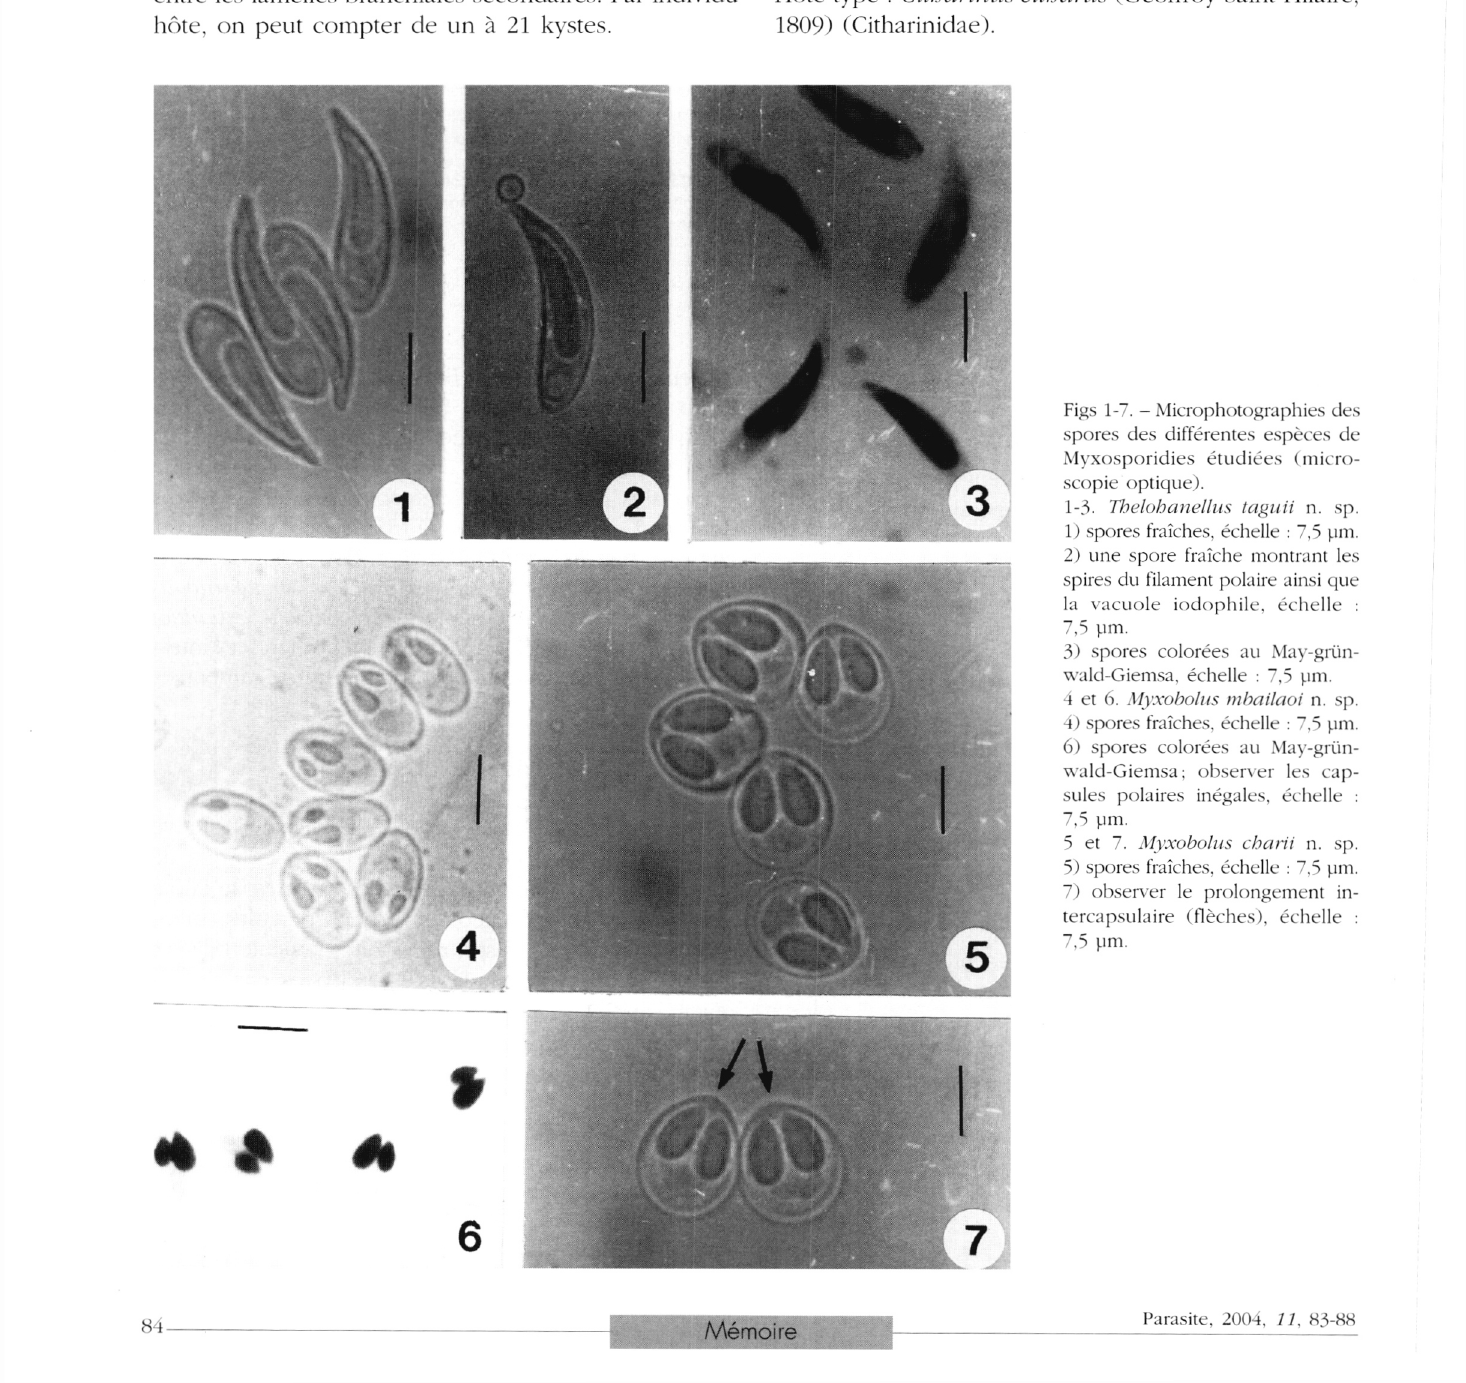
Figs 1-7. - Microphotographies des spores des différentes espèces de Myxosporidies étudiées (micro­ scopie